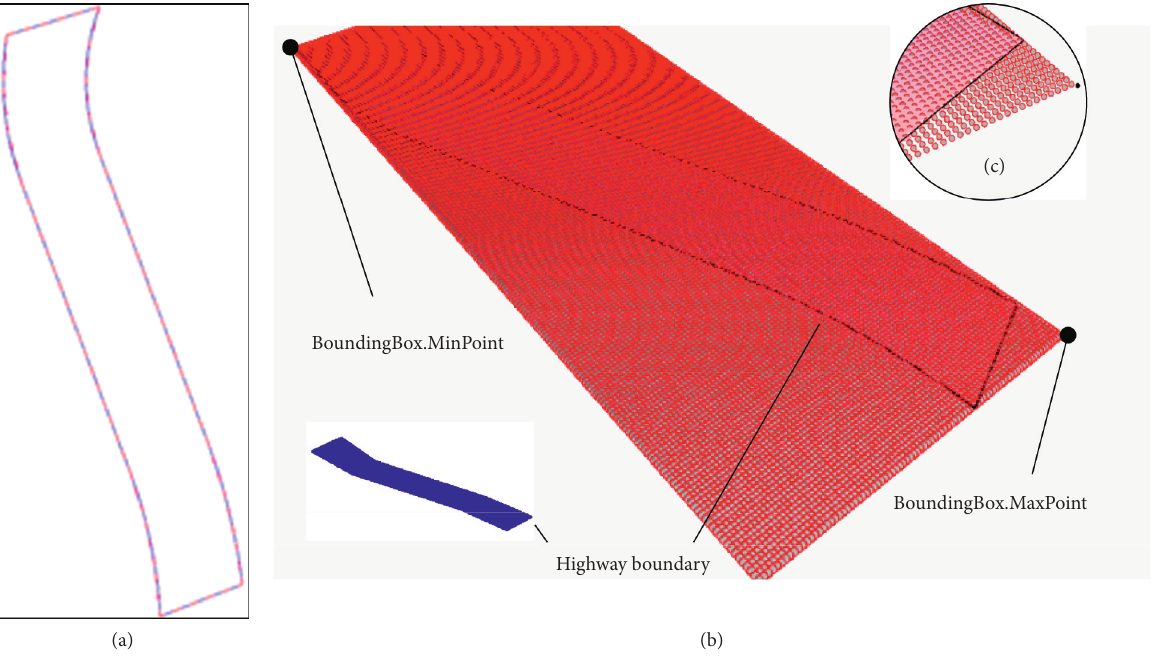
Figure 9: (a) The bounding box of the highway segment element. (b) Instantiate bounding box. (c) Limited cells of highway segments.